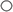
Antitumor activities of BC-02 in vivo. 3 × 106 H22 cells were injected to the enterocoelia of Kunming mice. Then, mice were divided into different groups and treated with BC-02 and capecitabine, and survival period was recorded (A). Capecitabine-resistant H22 cells was inoculated subcutaneously in KM mice, and they were treated with BC-02 and capecitabine. Then, mice body weight was monitored (D). After 2 weeks, all mice were sacrificed and dissected to weigh tumor tissues (B,C). “” means no tumor was found.